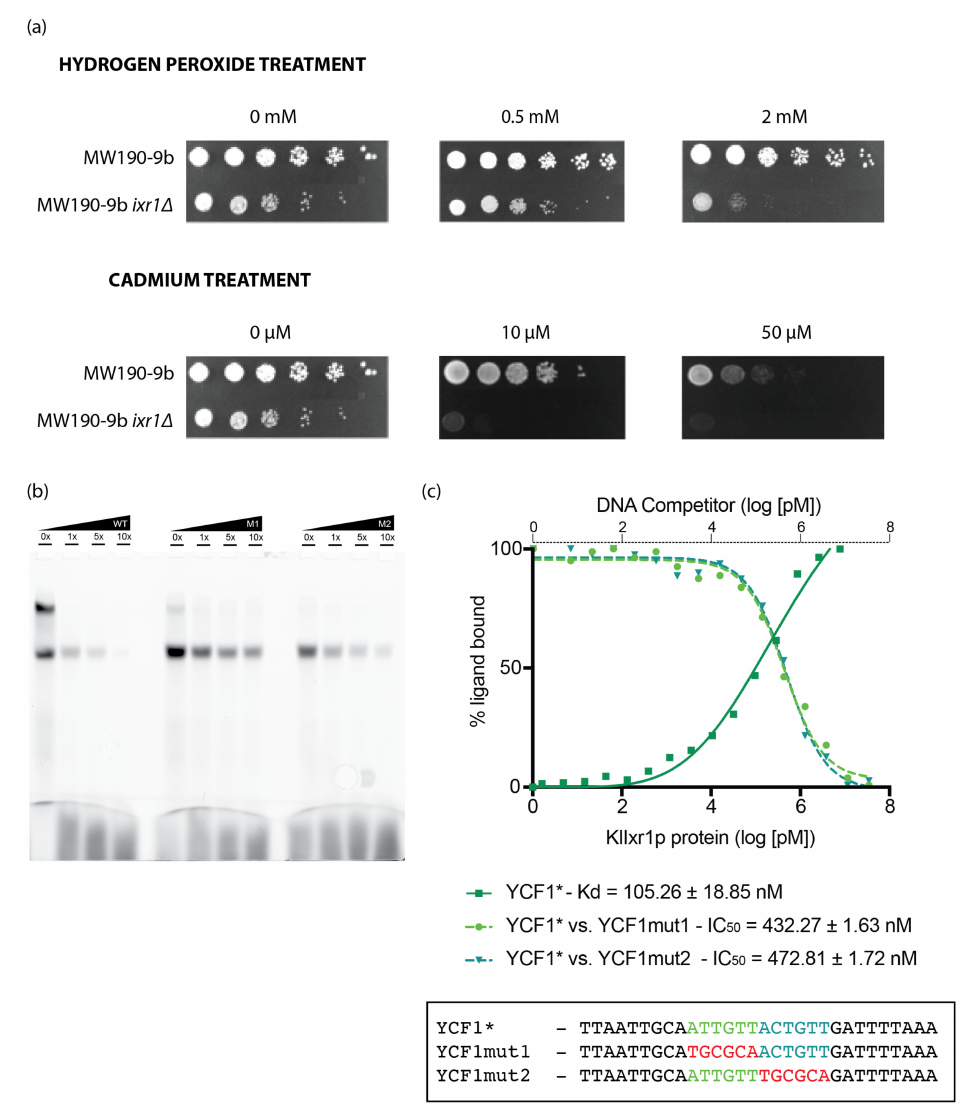
Figure 6. Analysis of the cellular response of MW190-9b strain and its derivative ixr1 ∆ to hydrogen peroxide and cadmium treatments. ( a ) Resistance to H 2 O 2 and cadmium in the wild type and klixr1 ∆ null strains. Serial dilutions of the cells (1, 10 − 1 , 10 − 2 , 10 − 3 , 10 − 4 , 10 − 5 ; from left to right) were made from an initial culture of OD 600 = 1.0 and were grown at 30 ◦ C for three days on CM plates supplemented with the indicated concentrations of compound. ( b ) EMSA assays for the KlYCF1 promoter region contains two putative contiguous binding sites for Kl IXR1 deduced by using the AYKGTT core consensus sequence [23] in silico searches. Competition assays were conducted with increasing amounts of non-labeled ligands indicated. WT: ligand not mutated; M1: ligand mutated in first site; M2: ligand mutated in second site. ( c ) Klotz plots representing quantitative analysis of Kl Ixr1 binding to KlYCF1 promoter-deduced site. DNA binding measured by fluorescence anisotropy changes of the 5 (cid:48) fluorescein labelled DNA (100 nM ligand) upon protein titration (Section 2). The resulting semi-log binding isotherms were fitted to a 1:1 binding model with non-linear least squares regression. Data points are the average of 3 independent experiments. Competition analysis of Kl Ixr1 binding to both KlYCF1 promoter deduced sites were measured by fluorescence anisotropy changes of the 5 (cid:48) fluorescein labelled DNA (100 nM ligand non mutated) bound to Kl Ixr1 protein (200 nM) and upon non-labeled DNA competitor titration ( Kl Ixr1 binding sites individually mutated). The resulting semi-log binding isotherms were fitted to a logIC50 competitive model with non-linear least squares regression. * indicates FAM labeled